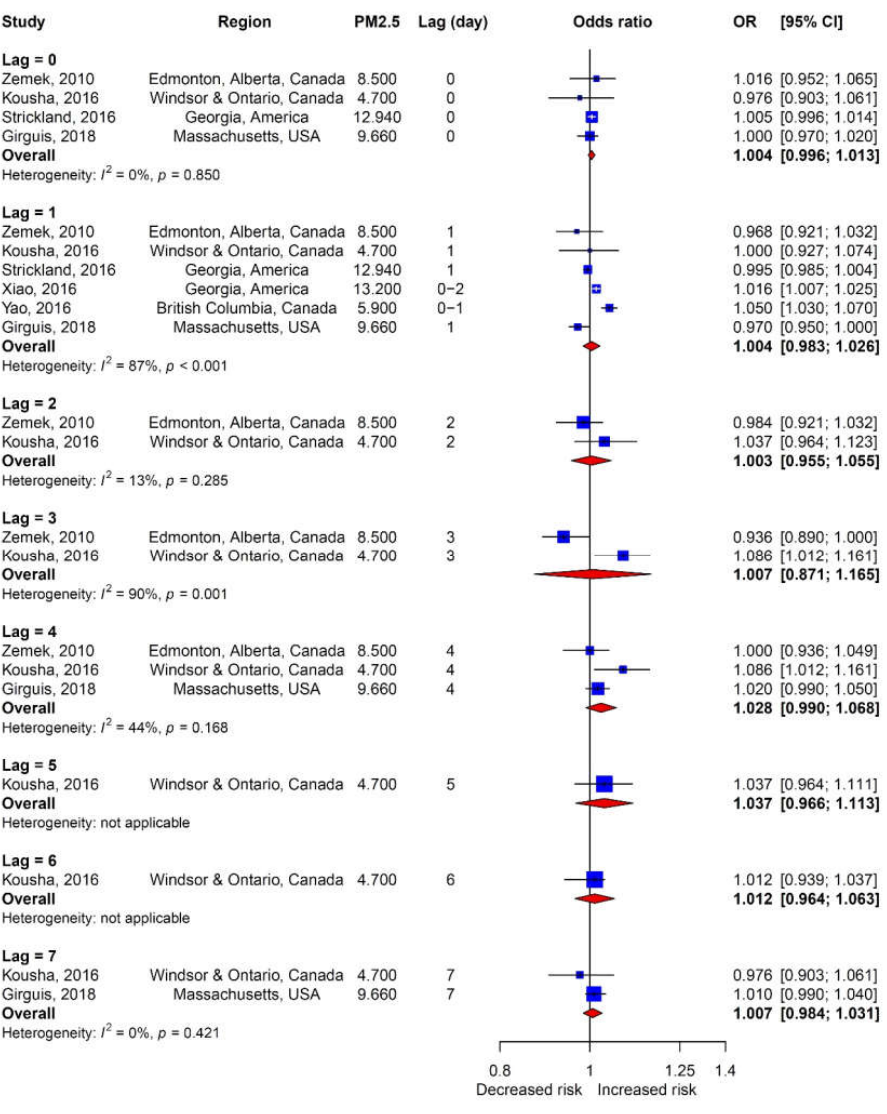
Figure 6. Association of lag with the incidence of OM.